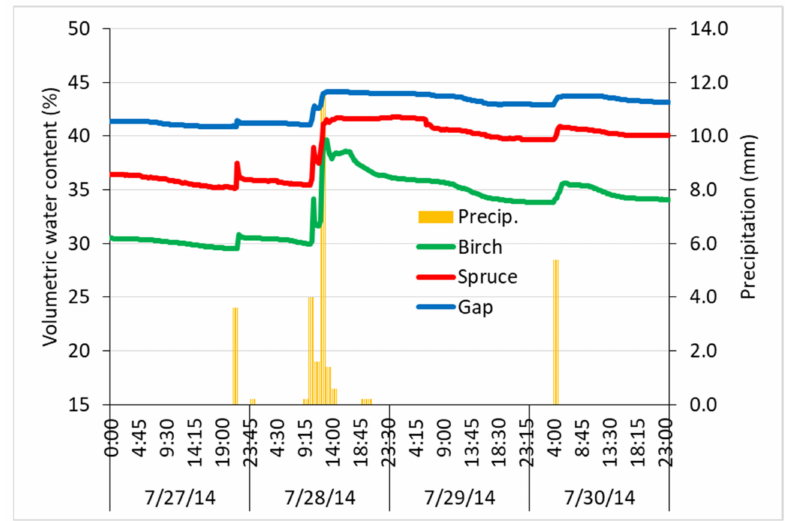
Figure 9. The 4-day summer period showing the average volumetric topsoil water content (%) response to rain events (mm per hour) under spruce, birch, and gap vegetation in